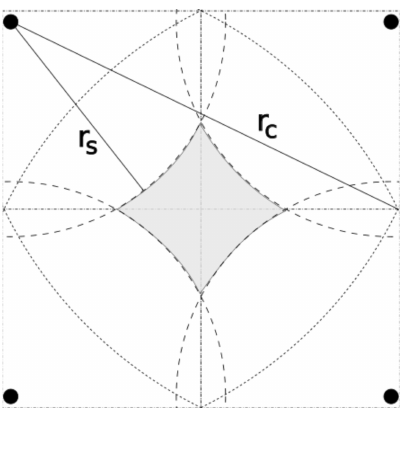
Figure 6. Sensing coverage with the original version of